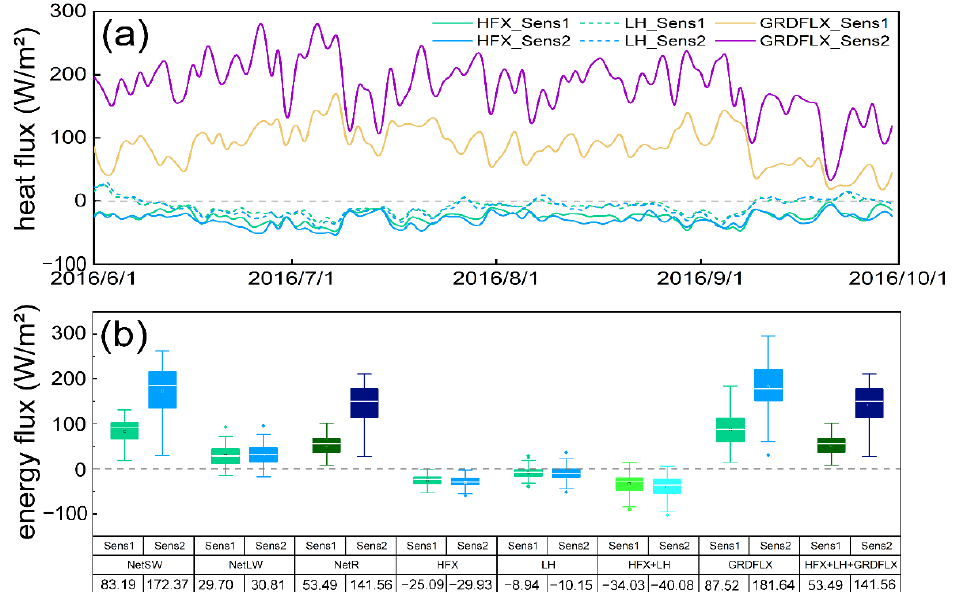
Figure 6. Comparison between the Sens1 and Sens2 estimates of the daily mean near-surface sensible (HFX, + to atmosphere), latent (LH, + to atmosphere), ground (GRDFLX, + to soil) heat fluxes ( a ) and each component of the surface heat budget ( b ), NetSW: net shortwave radiation; NetLW: net longwave radiation; NetR: net radiation).